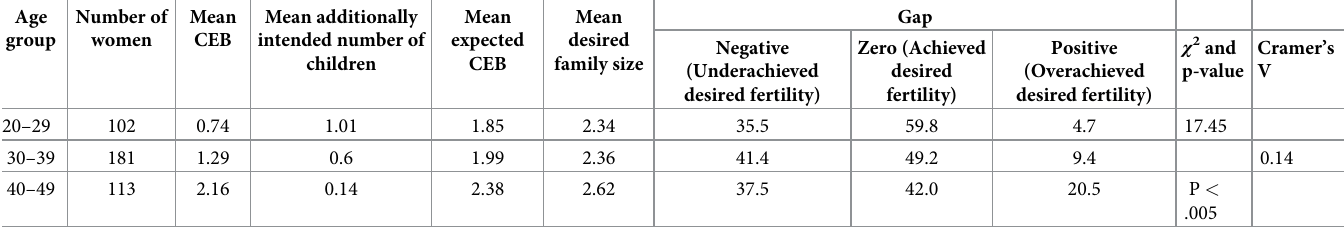
Table 1. Mean number of children ever born (CEB), mean expected CEB, mean desired family size and the gap between mean CEB and mean expected CEB by cur- rent